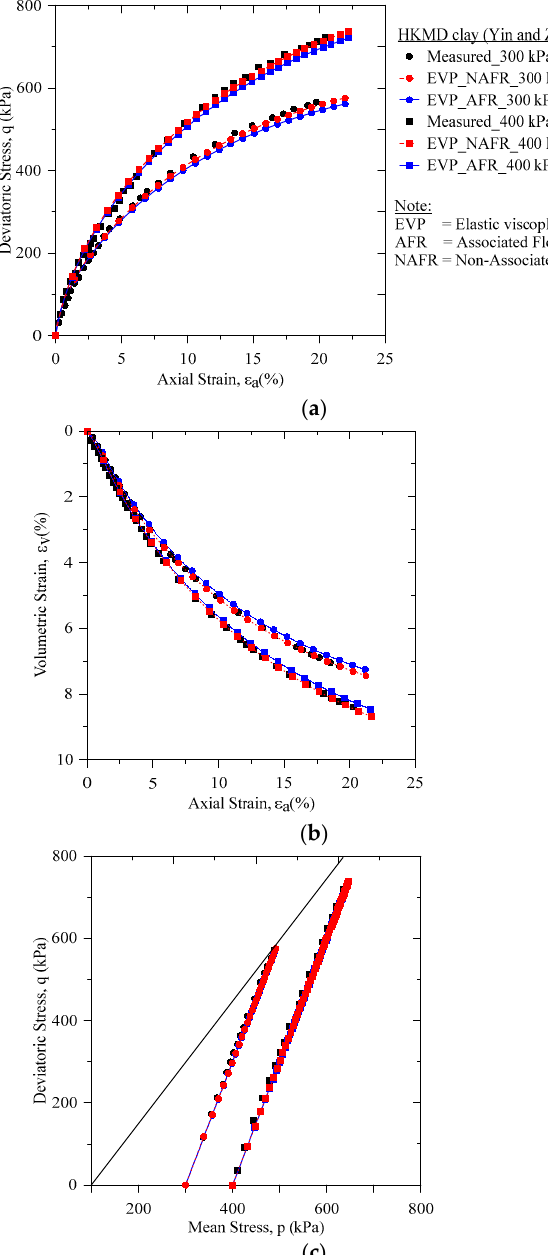
Figure 8. Comparison of the measured and the predicted consolidated drained triaxial compression tests on the HKMD clay: ( a ) the deviatoric stress vs. the axial strain; ( b ) the volumetric strain vs. the axial strain; and ( c ) the stress